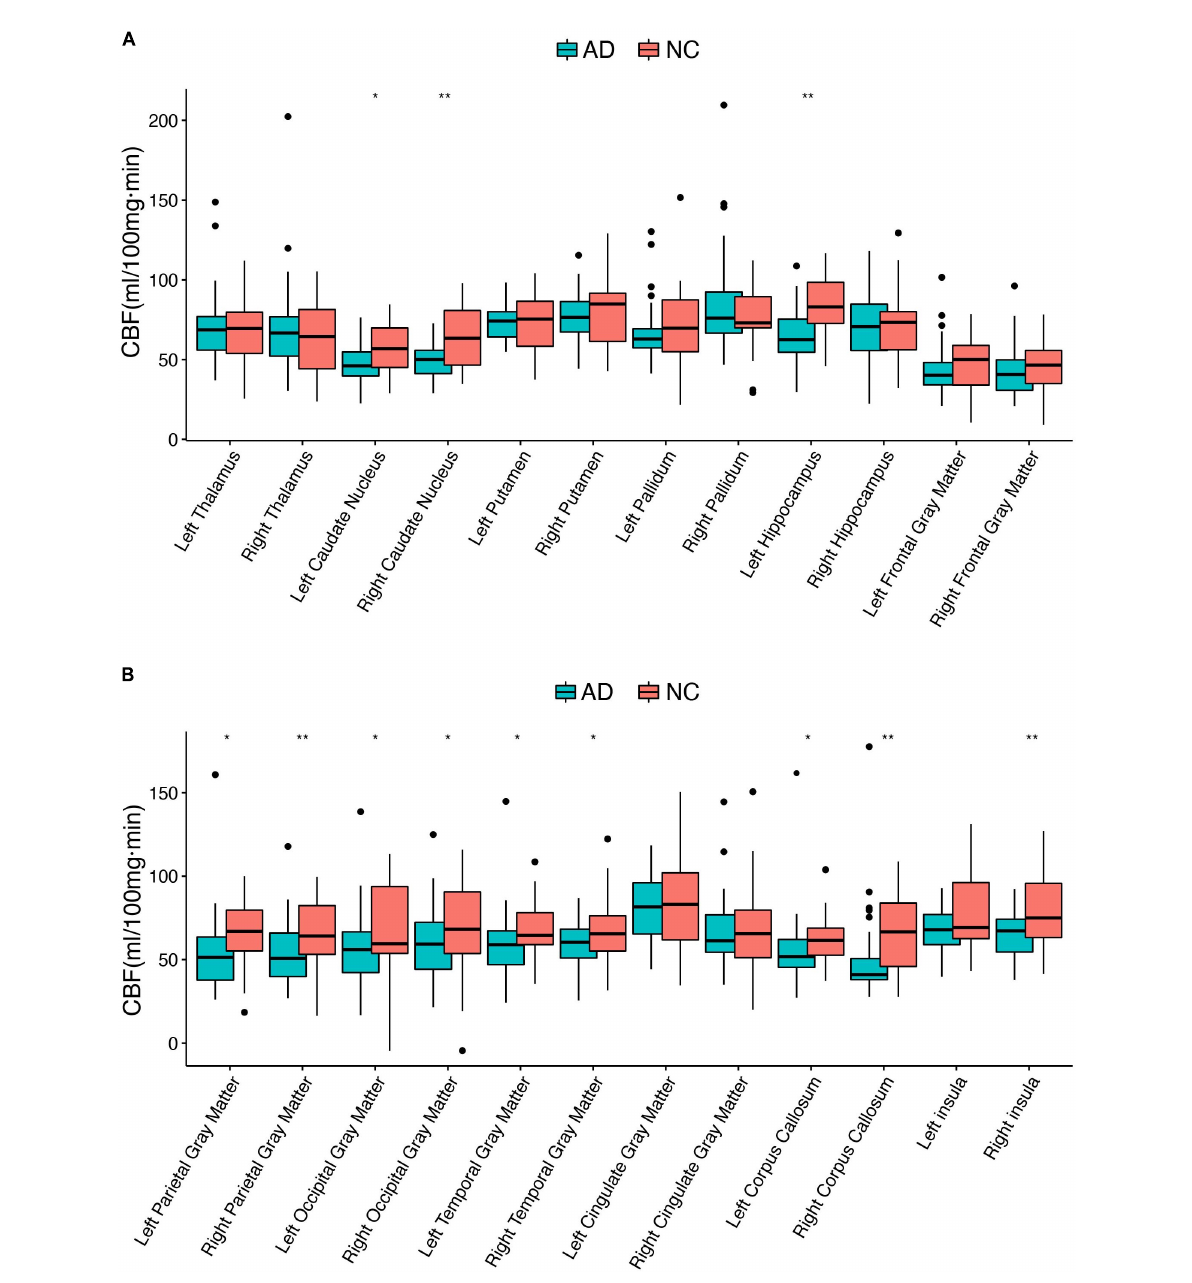
FIGURE1 Differential cerebral blood flow between AD and NC individuals in 24 brain regions. AD, Alzheimer’s disease; CBF, cerebral blood flow; NC, normal controls; *corrected p < 0.05; **corrected p < 0.01. (A,B) Boxplots of the CBF in different brain